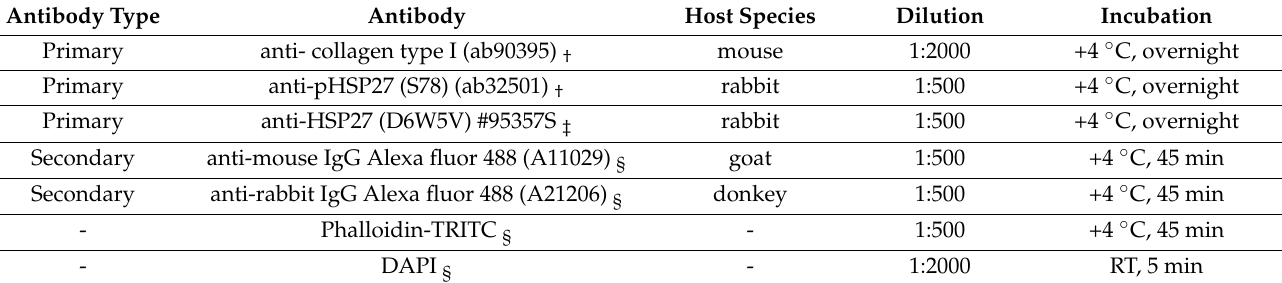
Table 2. Reagents used in ICC